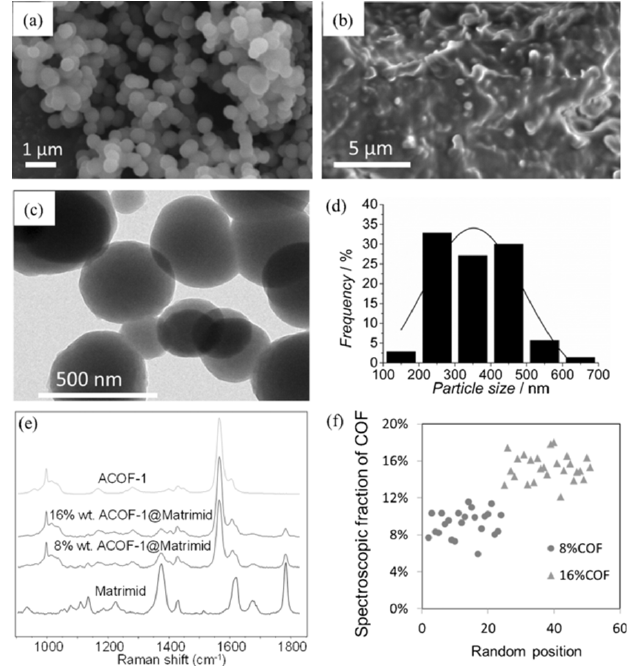
Figure 15. SEM images of ( a ) ACOF-1 and ( b ) the cross-section of a 16 wt % ACOF-1@ Matrimid ® MMMs. TEM images ( c ) and particle-size distribution ( d ) of ACOF-1. ( e ) Raman spectra of the pure components and MMMs. ( f ) Spectroscopic fraction of COF calculated at random positions of two different MMMs (8 and 16 wt % COF loading). Reprinted with permission from [127], Copyright (2016) John Wiley and Sons publications.